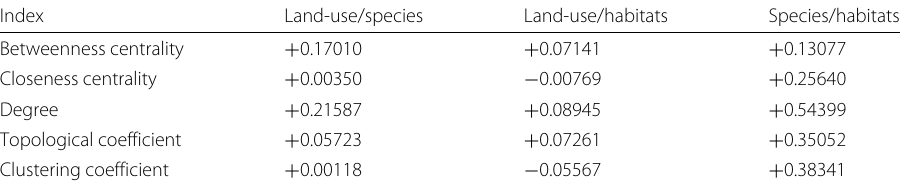
Table 6 Spearman correlation of various complex network indices, between pairs of similarity-based graphs built using Jaccard coefficients